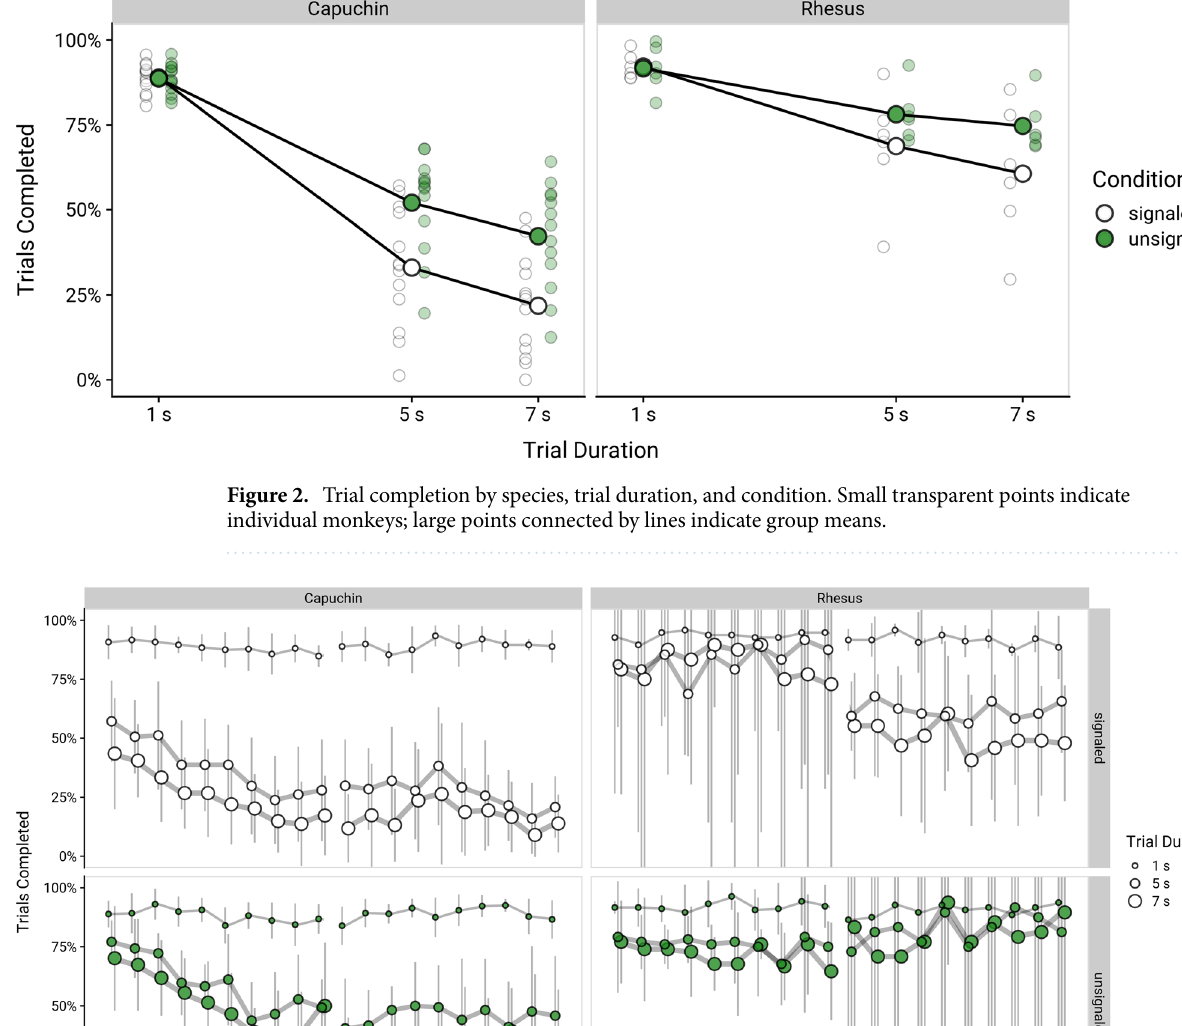
less likely to do so ( OR ± SE 5 s: 4.13 ± 0.27, 7 s: 5.52 ± 0.36, p s < 0.001), suggesting that they suffered more from sunk cost effects than capuchins. Further, when the trial duration was signalled through a change in background colour, rhesus macaques ( OR ± SE 5 s: 1/0.79 = 1.27 ± 0.07, 7 s: 1.50 ± 0.06, p s < 0.001) and especially capuchin monkeys ( OR ± SE 5 s: 2.37 ± 0.02, 7 s: 2.88 ± 0.02, p s < 0.001) became even more likely to opt out of the trial.